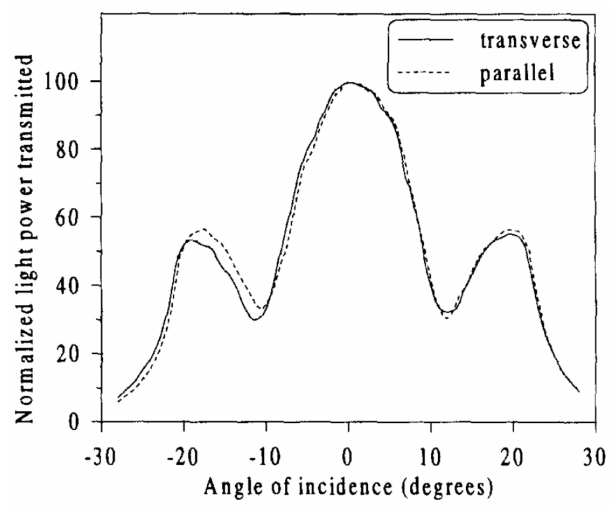
Figure 9. Experimental curves of the normalized angle-resolved power for di ff erent polarization states [51]. Copyright 1996,